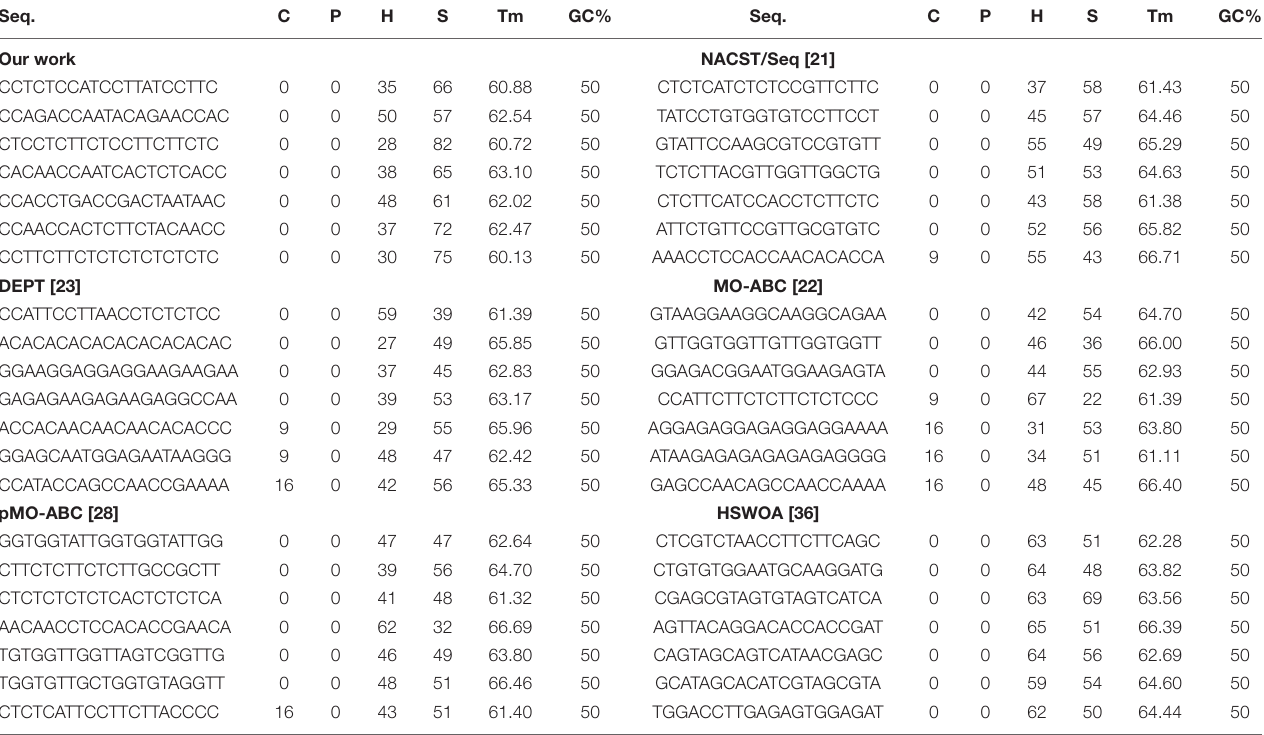
TABLE 3 | Comparing sequences from NACS/Seq, DEPT, MO-ABC, pMO-ABC, and HSWOA. Seq.